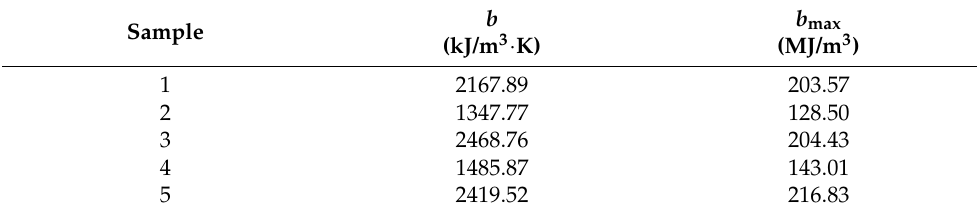
Table 7. Volume thermal capacity of the tested materials.